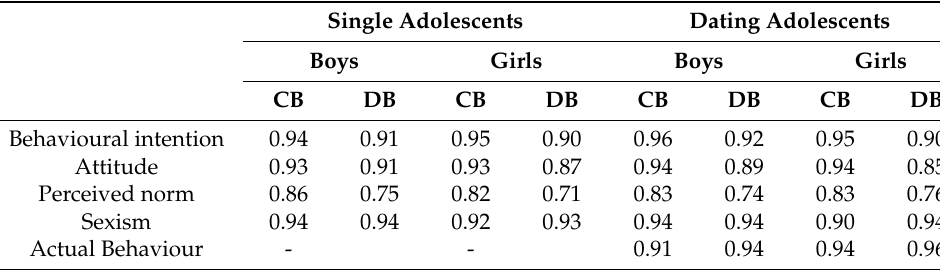
Table 1. Internal consistency of boys’ and girls’ subscales for controlling and devaluing